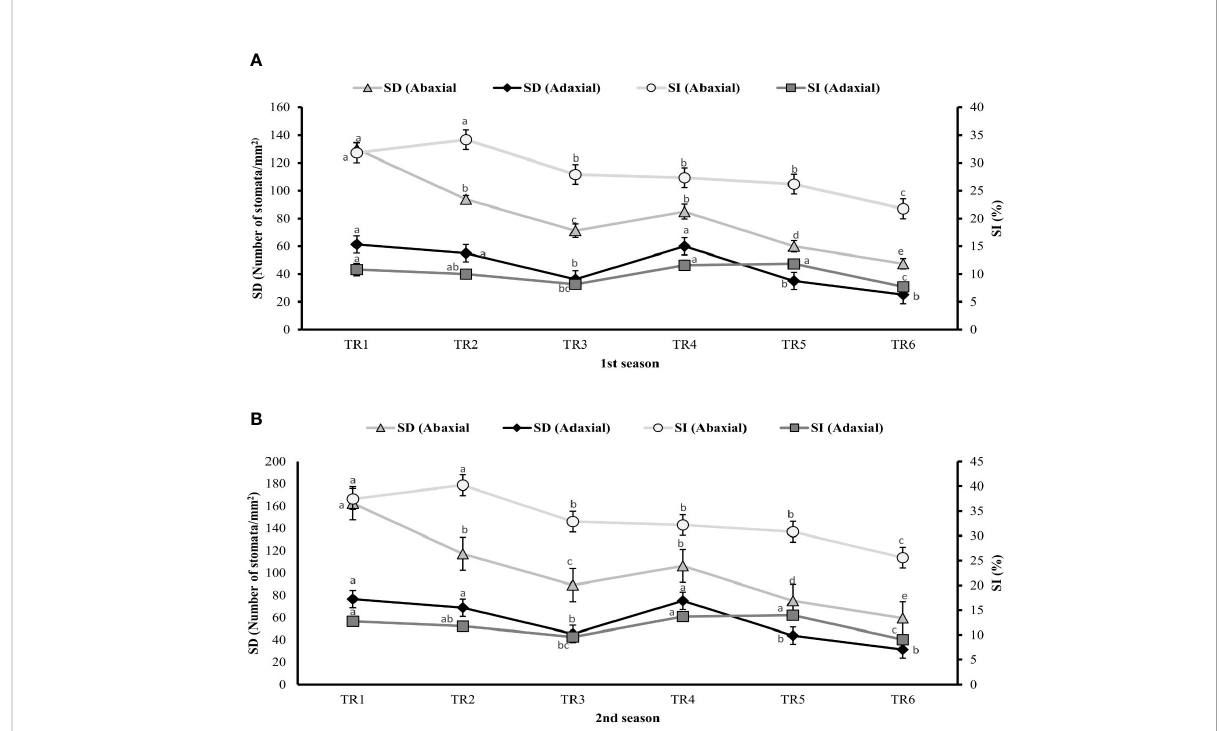
FIGURE 4 Effect of foliar application of ZnOx nanoparticles (NPs; 100 ppm) on stomatal density and stomatal index in the (A) fi rst and (B) second seasons at different irrigation regimes. The graph values are the mean ± SE of four replicates. Bars exhibited with different alphabets indicate the signi fi cant difference between samples by least signi fi cant difference (p ≤ 0.05). TR1: FI, TR2: FI + ZnO NPs, TR3: MDR, TRT4: MDR + ZnO NPs, TRT5: IDR, and T6: IDR + ZnO